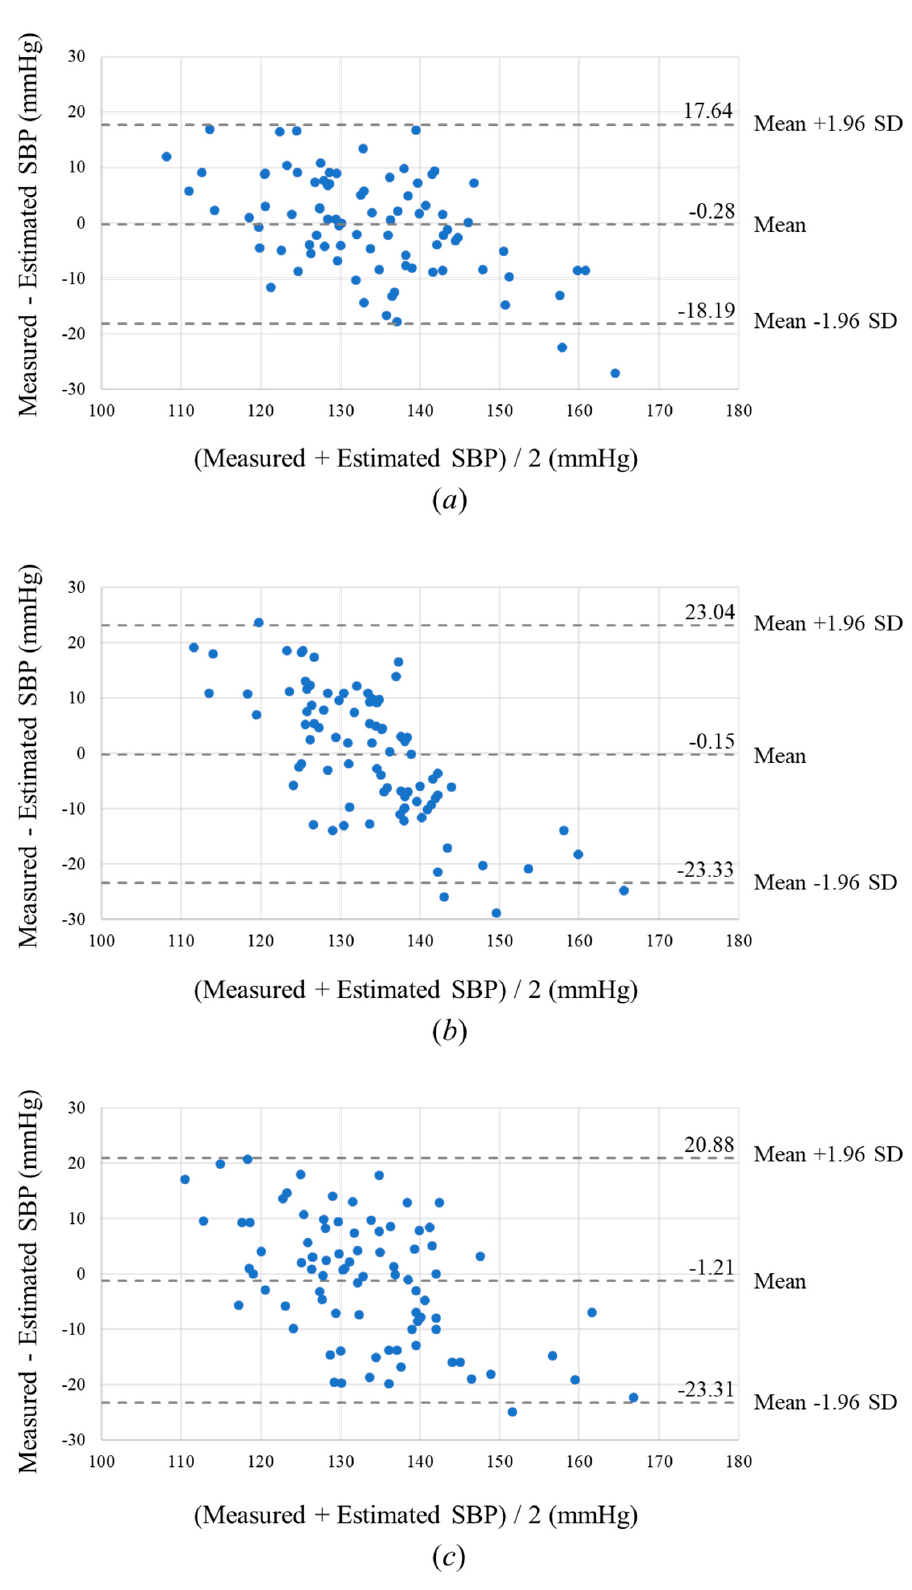
Figure 6. Bland–Altman plots of the results: ( a ) our proposed method, ( b ) comparison method 1, and ( c ) comparison method 2.